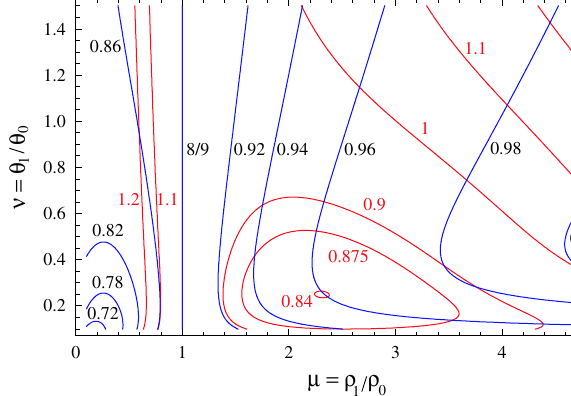
120 (cid:13)(cid:14) 5 þ 60 (cid:14) 4 . To visualize this function, its contour lines are shown in Fig. 2, together with the exact results for bending angles at (cid:15)= 5 and (cid:15)= 2 which show a negli-